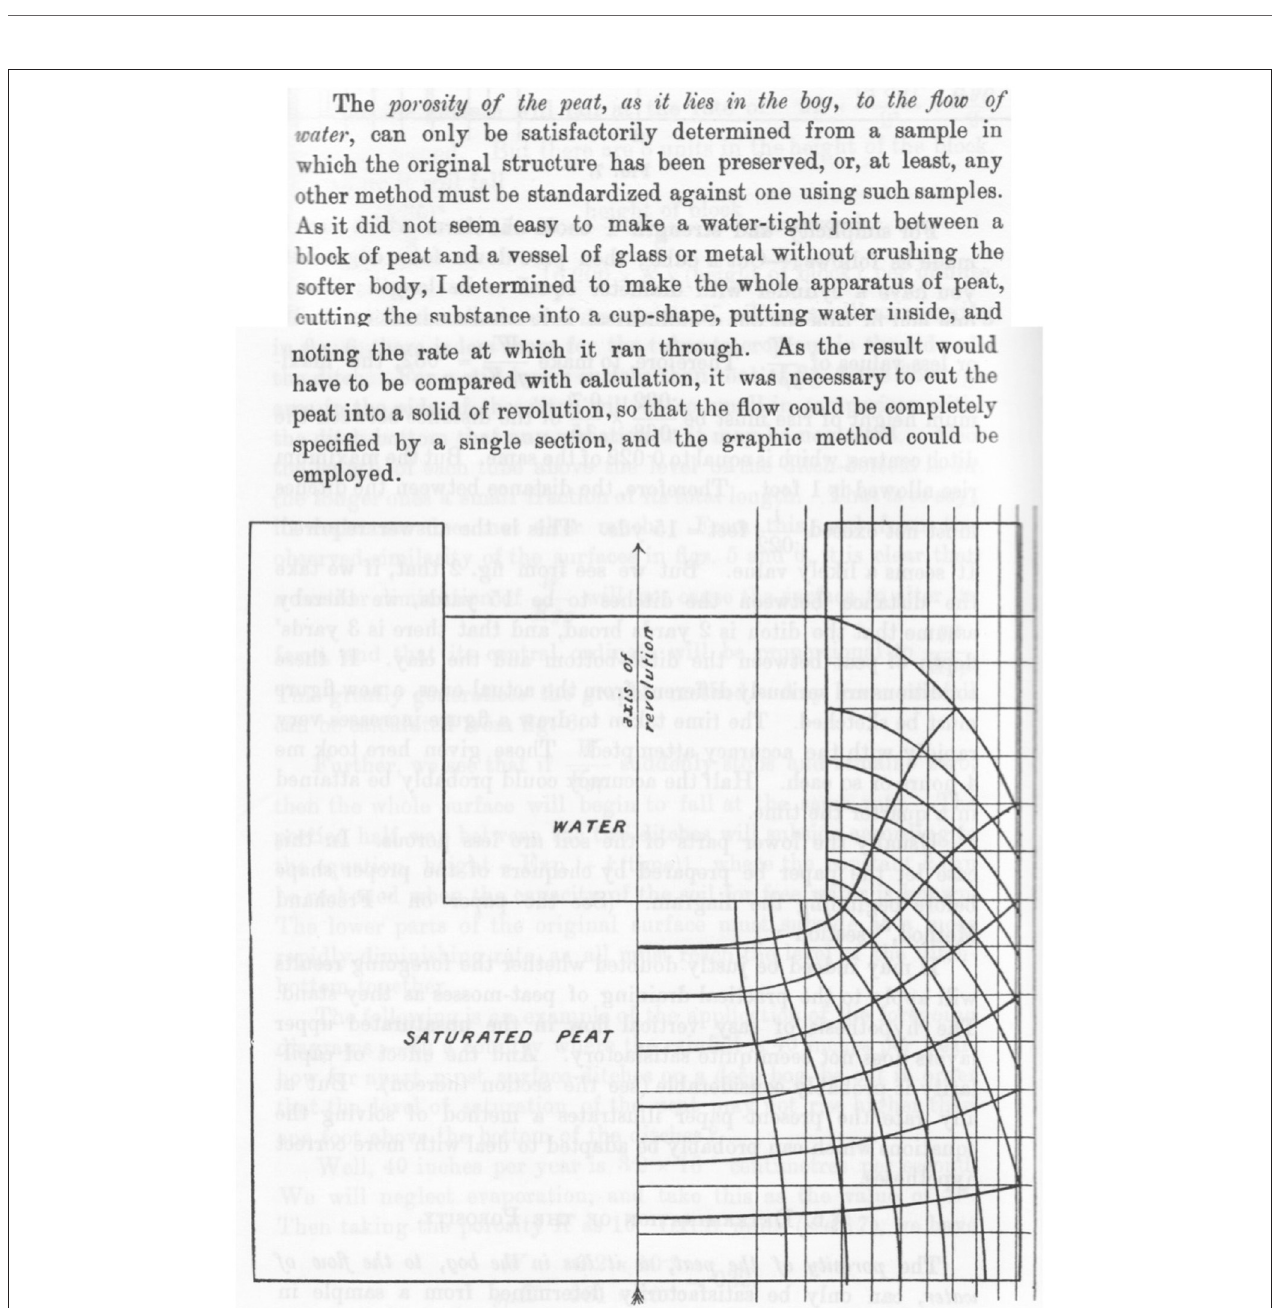
FIGURE 6 | Determination of hydraulic conductivity, using a cylindrical sample with water delivery hole. Copied from text and Figure 7 in Richardson (1908b), with permission from the Royal Dublin Society (RDS).